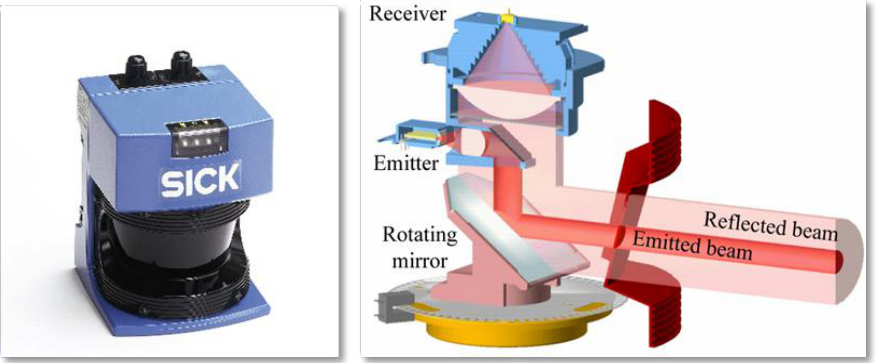
Figure 1. LMS200 laser sensor (SICK AG) and its principal internal